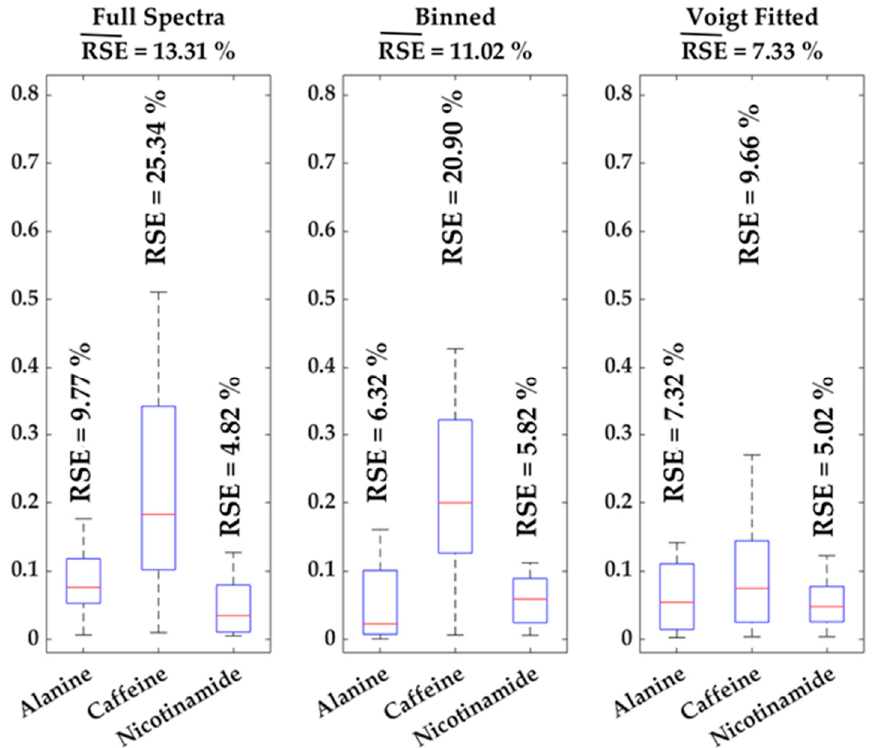
Figure 3. Boxplots of standard errors of relative quantification for all three spiked metabolites and methods, individual relative standard errors (RSE) are given as well as the mean RSE (RSE ) for each method .